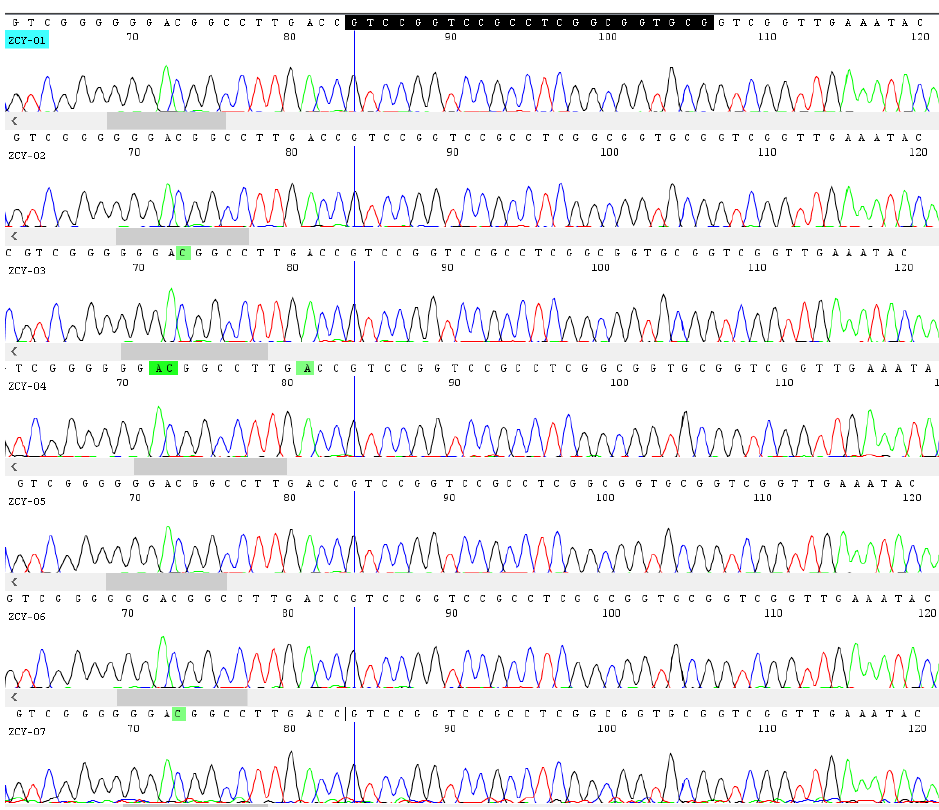
Figure 2. Sequencing peak profiles of seven batches of Chinese patent medicine containing Ephedra herb.